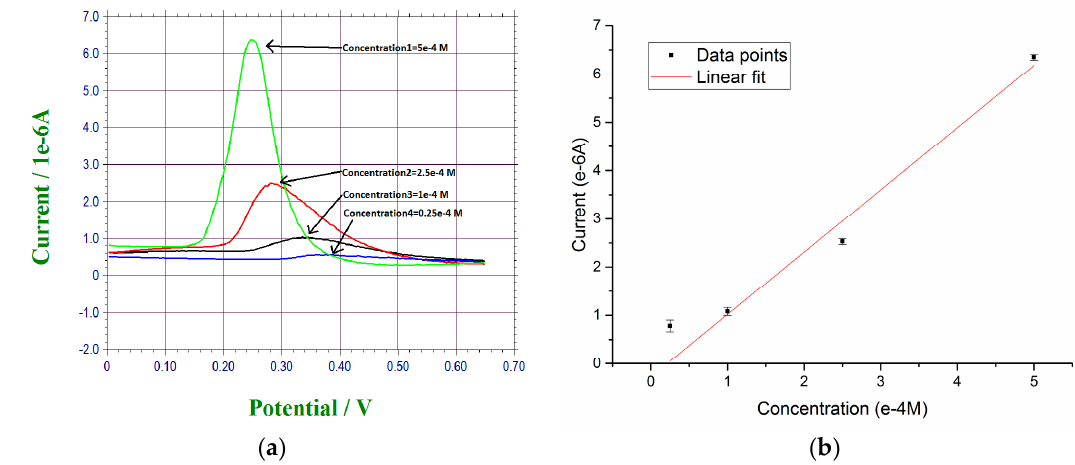
Figure 6. ( a ) DPV measurement of lead ions concentration level ranging from 5 × 10 − 4 M to 2.5 × 10 − 5 M; ( b ) Calibration curve for the DPV measurement data points.